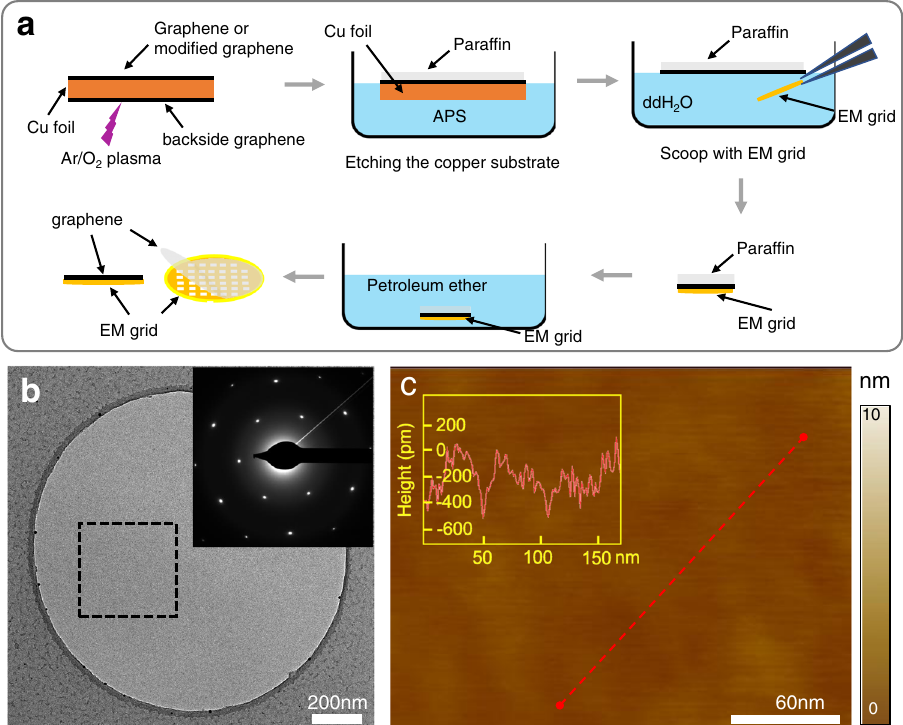
Fig. 1 | Paraf fi n-assisted graphene transfer on EM grids. a Scheme of paraf fi n- assisted graphene transfer onto EM grids. b A high-magni fi cation TEM image of graphene grid transferred by paraf fi n. The inset was the selected area electron diffraction (SAED) pattern of the boxed region. Similar results have been repeated